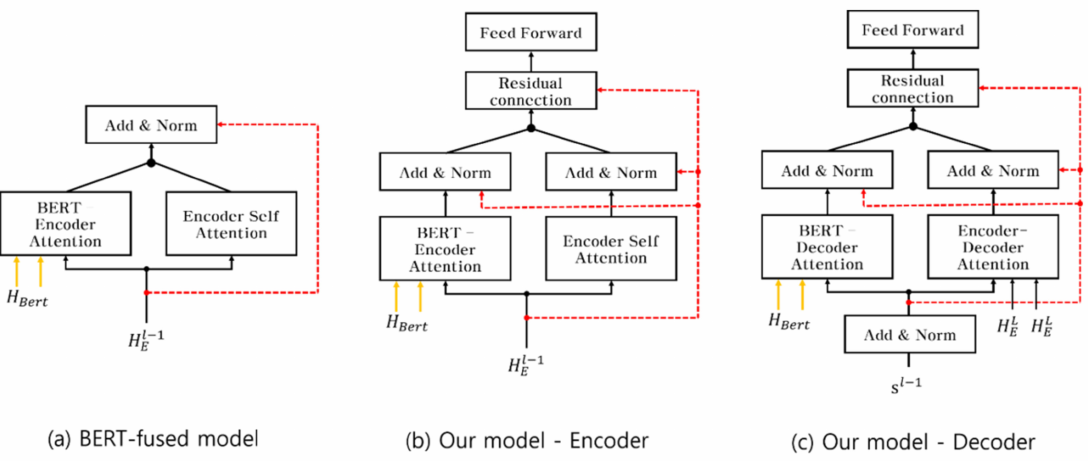
Figure 3. Differences among residual connections. The residual connection is denoted by the red line.